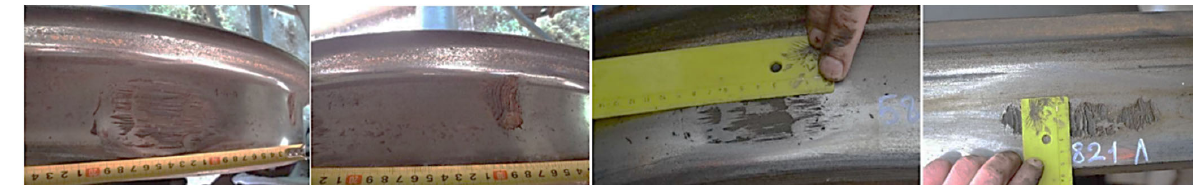
Figure 18. Values of Q M considering to the mean vertical forces of unloaded goods wagon.